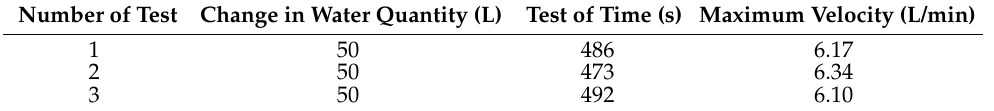
Table 7. Flow velocity measurement result.